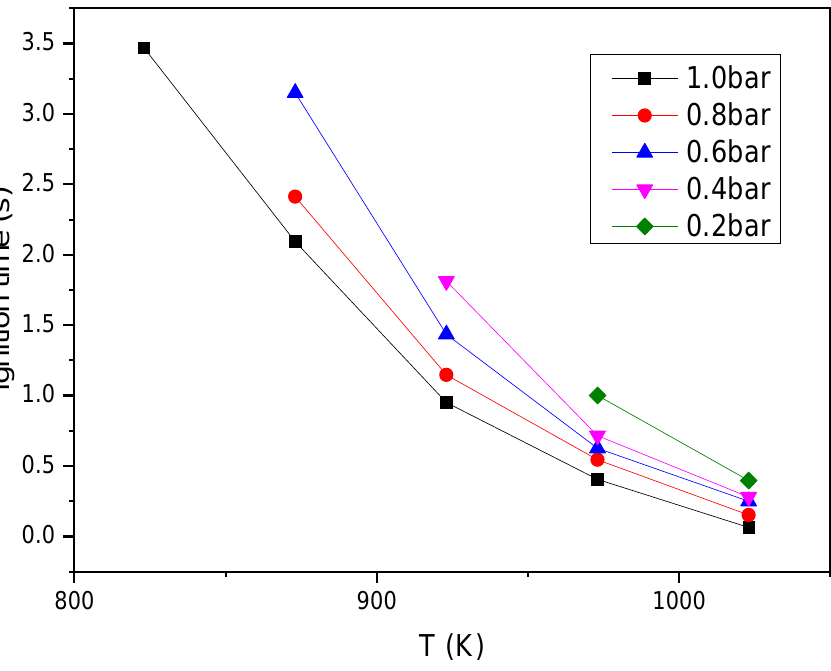
Figure 8. Ignition time under different pressure and temperature conditions.